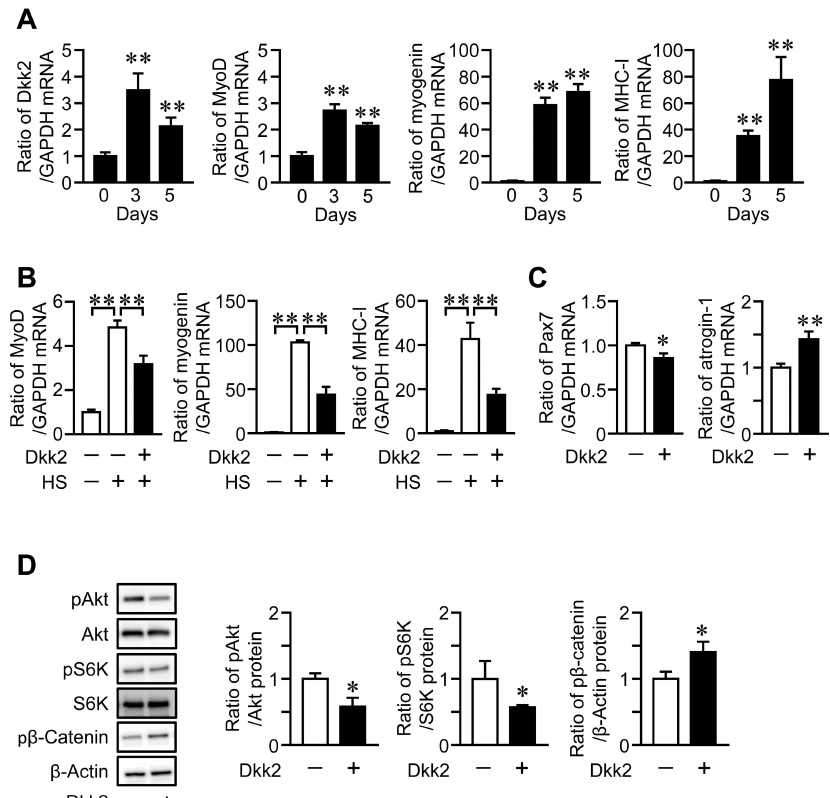
Figure 5. E ff ects of Dkk2 in muscle cells. ( A ) C2C12 cells were grown until confluent (day 0), and then cells were cultured with 2% horse serum for further 3 or 5 days. Total RNA was extracted from the cells, and real-time PCR analysis of myogenic di ff erentiation 1 (MyoD), myogenin, myosin heavy chain (MHC)-I, Dkk2 or GAPDH was performed ( n = 6 in each group). Data represent the mean ± SD of six experiments in each group. ** p < 0.01 vs. day 0 (Dunnett test). ( B ) Total RNA was extracted from confluent C2C12 cells ( − ) or C2C12 cells cultured in 2% horse serum (HS, + ) with ( + ) or without ( − ) 500 ng / mL Dkk2 for 5 days ( n = 6 in each group). Then, real-time PCR analysis of MyoD, myogenin, MHC-I or GAPDH was performed. Data represent the mean ± SD of six experiments in each group. ** p < 0.01 (Tukey-Kramer test). ( C ) Total RNA was extracted from C2C12 cells cultured with ( + ) or without ( − ) 500 ng / mL Dkk2 for 24 h ( n = 5 in each group). Then, real-time PCR analysis of Pax7, atrogin-1 and GAPDH was performed. Data represent the mean ± SD of five experiments in each group. ** p < 0.01 and * p < 0.05 (Mann-Whitney U test). ( D ) Total protein was extracted from C2C12 cells cultured